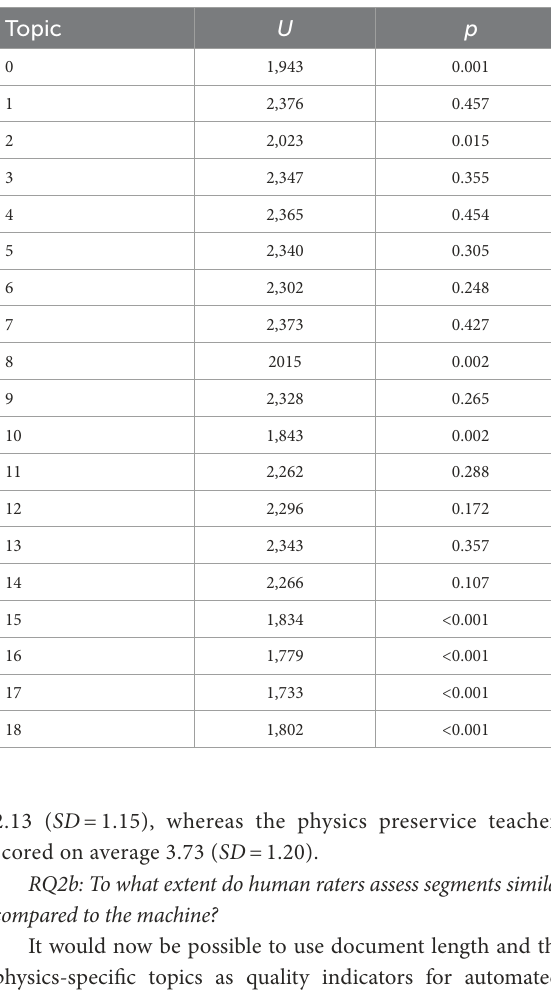
TABLE 6 Computer-human agreement on coding the computer- scored written reflections.